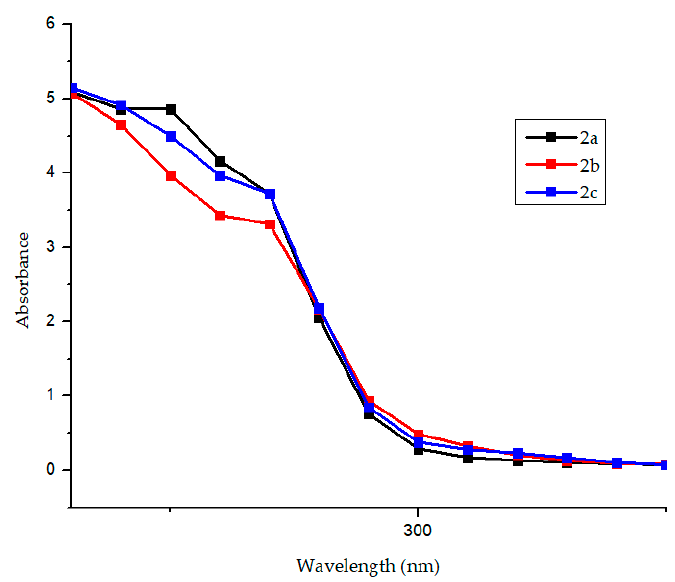
Figure 1. UV-Vis spectra of 2a , 2b and 2c in DMSO (conc. = 1 × 10 − 6 mol/L).